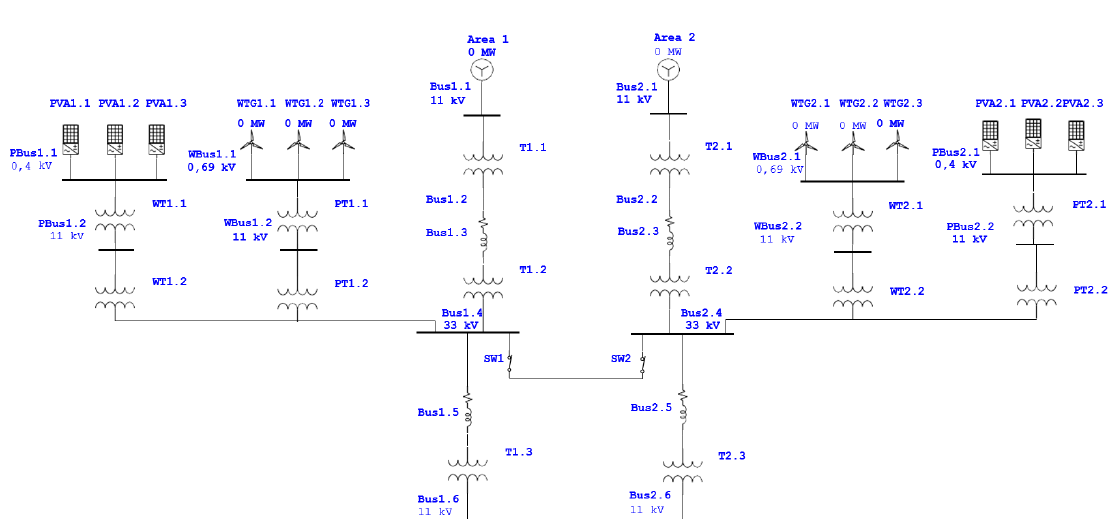
Figure 1. System model.